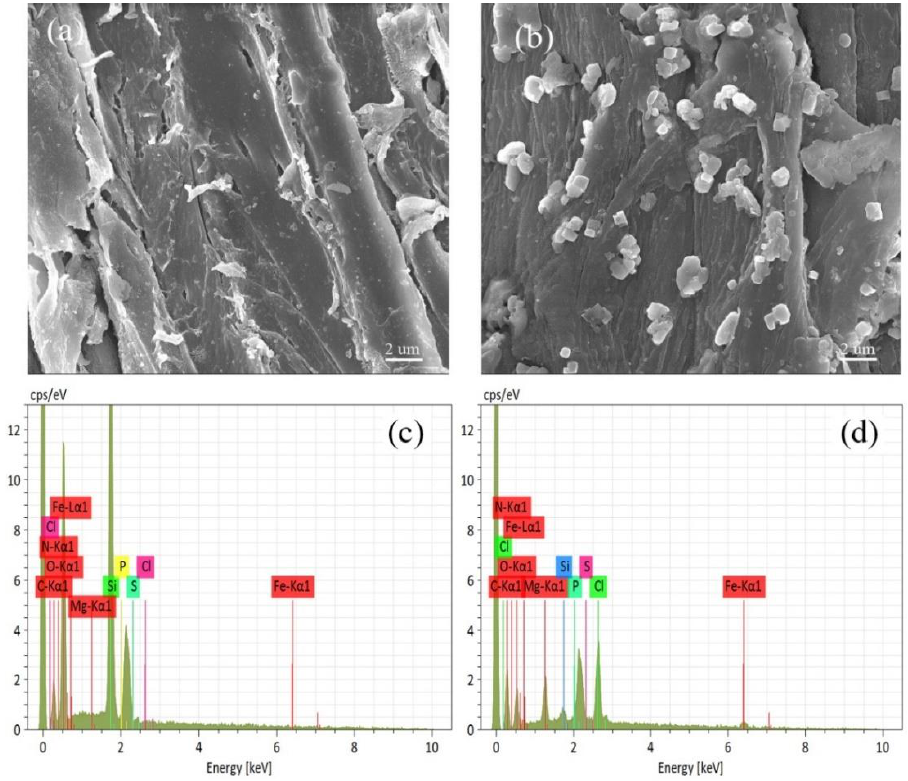
Figure 1. SEM of RSB ( a ) and Fe/Mg-RSB ( b ); EDS of RSB ( c ) and Fe/Mg-RSB ( d ).